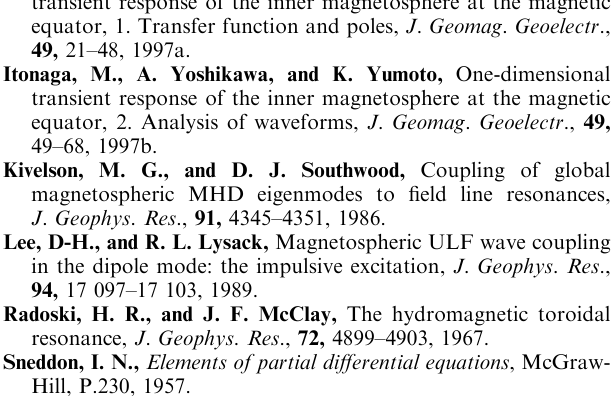
Fig. 4. The Fourier transform of Y for t (cid:21) p s. The Fourier 3 transforms of Y and Y have been scaled by a common factor 1 3 (di(cid:128)erent from Fig. 2), chosen such that the peak value of the transform of Y is approximately equal to 1